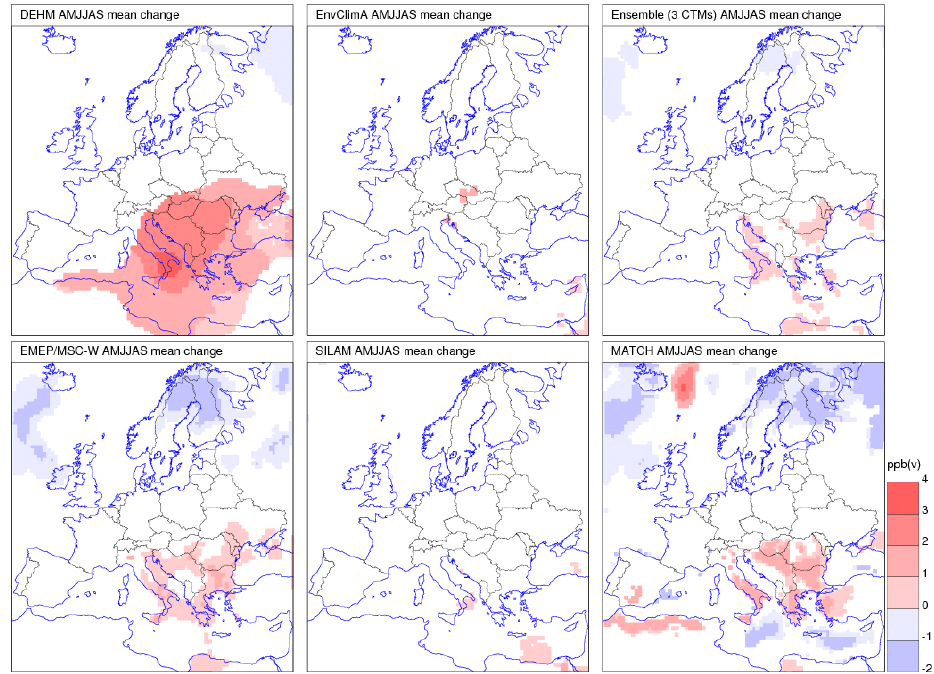
Fig. 9. Simulated April–September change 2000–2009 to 2040–2049 in average O 3 concentration at the first model level. Only changes that are statistically significant at the 95% level are plotted.